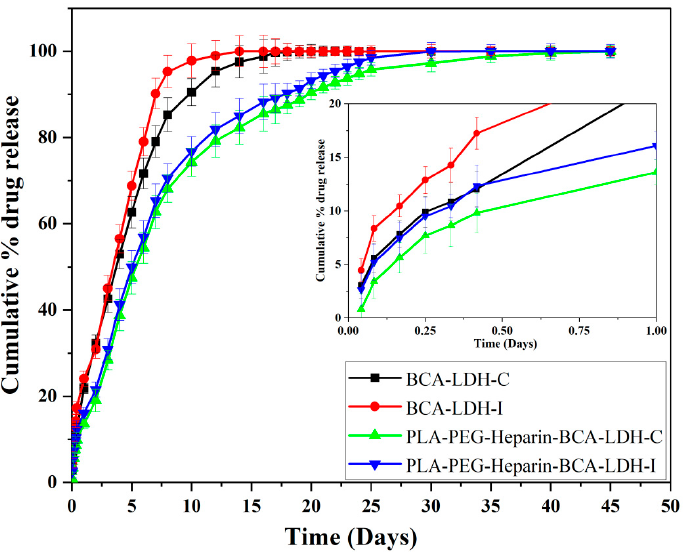
Figure 14. Cumulative drug release profile of BCA-LDH-C, BCA-LDH-I, PLA-PEG-heparin-BCA-LDH-C, and PLA-PEG-heparin-BCA-LDH-I in PBS (pH ≈ 7.4) for 50 days (n = 3), (inset displaying the release profile in 1st day). LDH-C, and PLA-PEG-heparin-BCA-LDH-I in PBS (pH the release profile in 1st